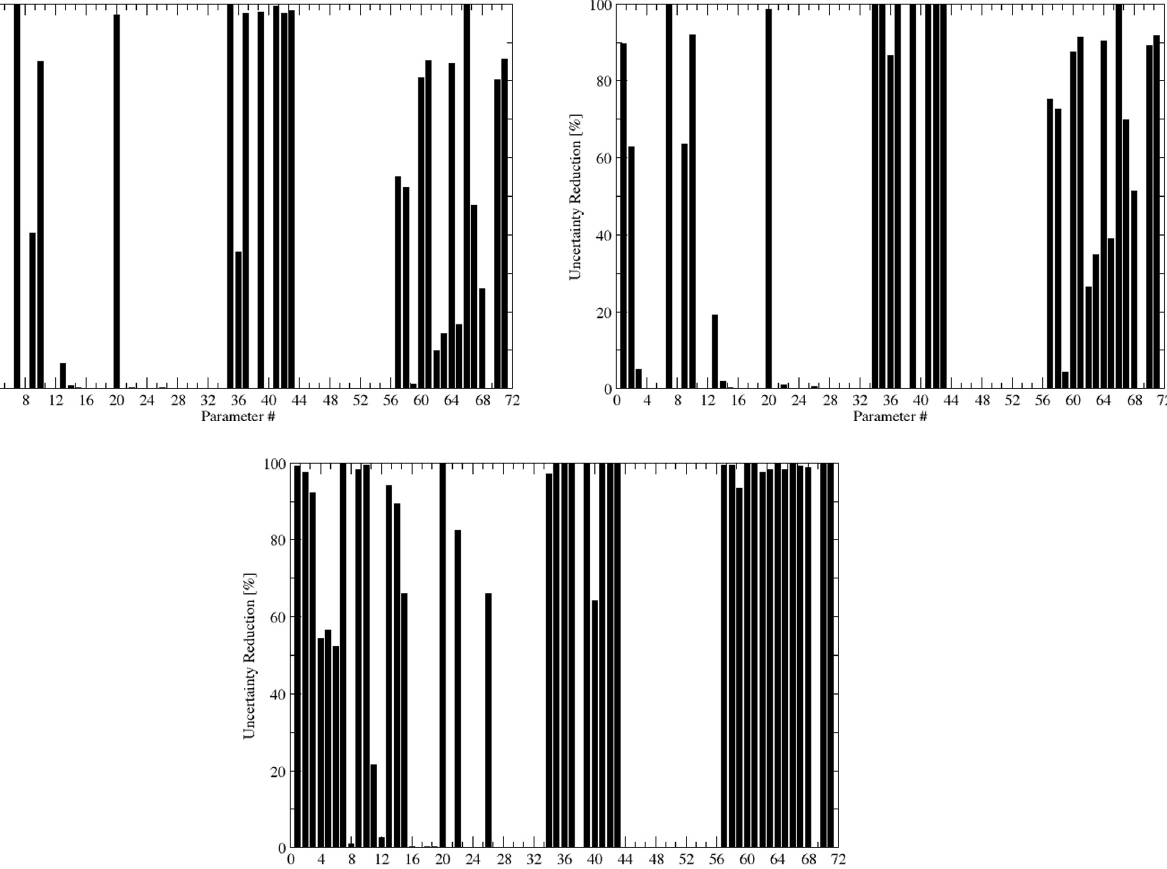
Fig. 9. Reduction in parameter uncertainty for a 14-yr mission for FAPAR data from the MERIS sensor (top left hand panel) a hypothetical higher resolution sensor (top right hand panel) and from a hypothetical ideal resolution sensor (bottom